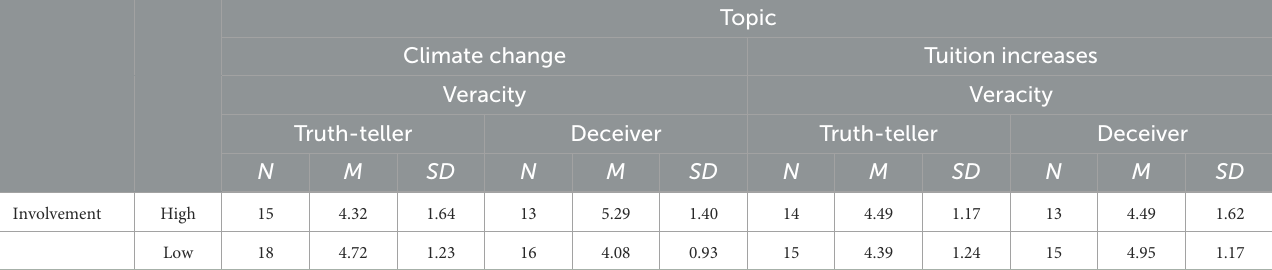
TABLE 3 Means and standard deviations for the three-way interaction among involvement, topic, and veracity in predicting participants’ perceptions of how much they themselves initiated synchrony during the specific discussion of climate change or tuition increases.